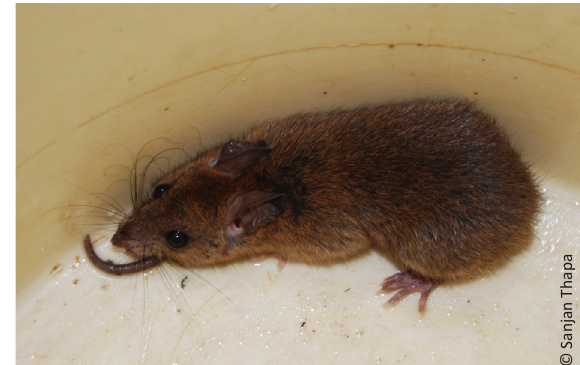
Image 12. Himalayan Rat Rattus pyctoris